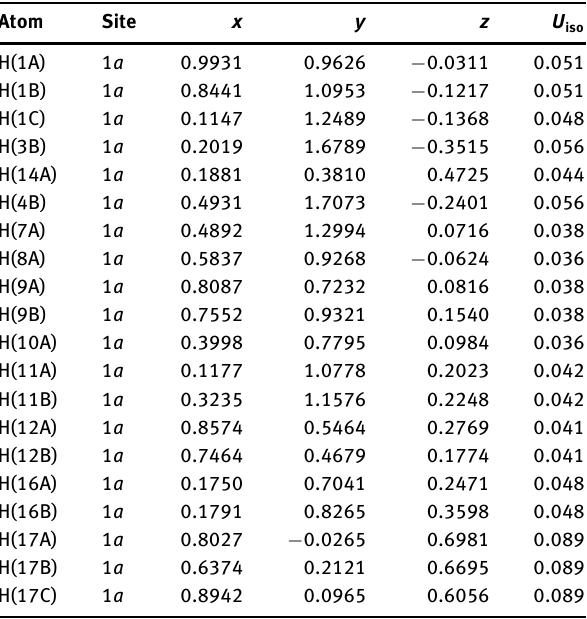
Table 2: Fractional atomic coordinates and isotropic or equivalent isotropic displacement parameters (Å 2 ).